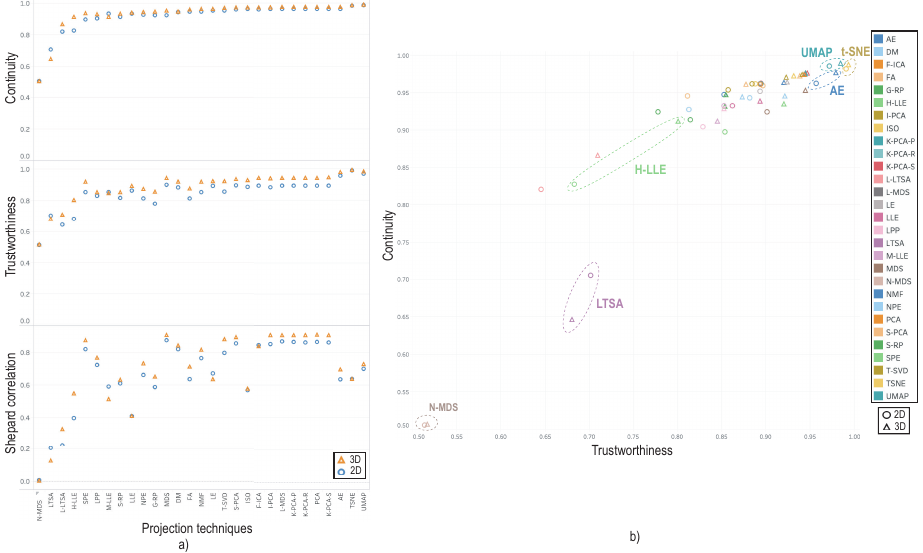
Figure 2. ( a ) Continuity, trustworthiness, and Shepard correlation, averaged for all datasets, for 2D and 3D projections. ( b ) Correlation of trustworthiness vs. continuity, averaged per projection over all datasets, for 2D and 3D